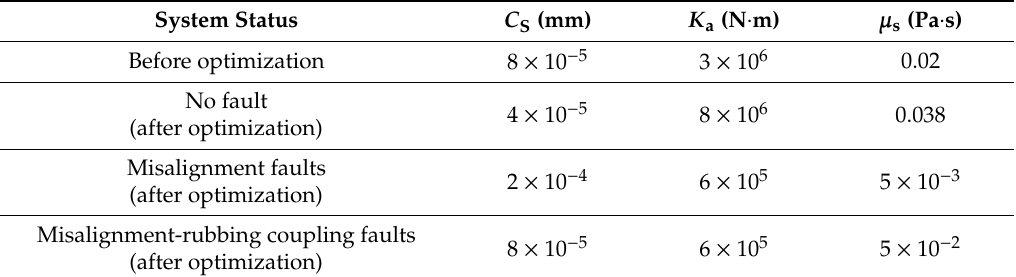
Table 3. SFD parameters of the rotor system under three